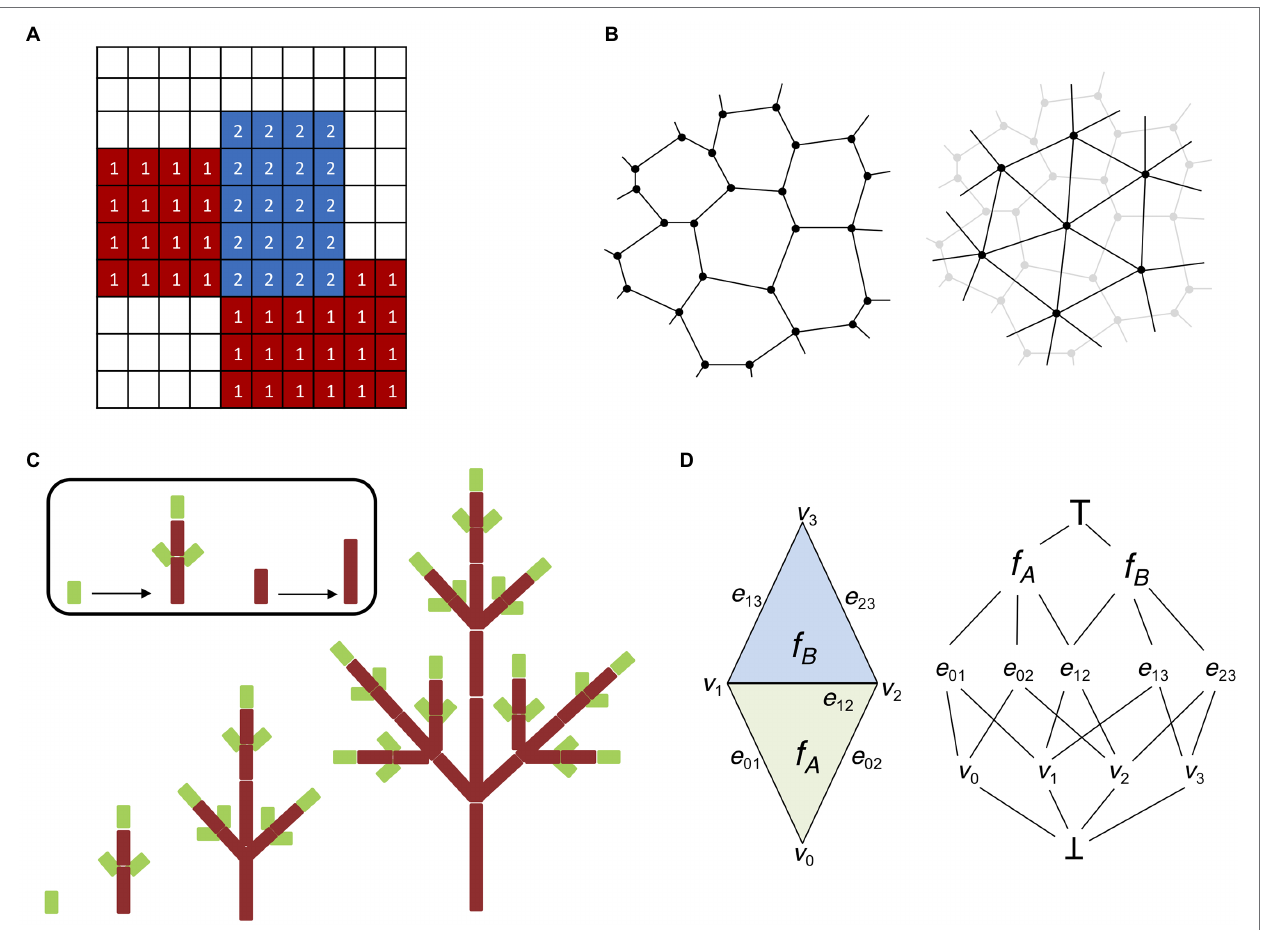
FIGURE 3 | Digital representations of plant tissues. (A) Lattice grid representing a basic cellular potts model (CPM). Each element (or pixel) of the grid possesses a specific identity; in this case, we have two cellular types (indicated by 1 and 2) and a medium (no labeling). CPMs are solved by minimizing the Hamiltonian energy of the system, which allows the elements of each cellular type to “group together” and isolate from the surrounding medium. (B) Two possible ways to represent multicellular tissues with vertex-based models. Cells can be identified by their cell walls (left). Cell walls are represented as polygons made of vertices connected by edges shared with adjacent cells (in accordance with the biological properties of plant cell walls). Cells can be identified by their centroid (right). Cells are represented by a network of vertices and edges connecting the centroids of adjacent cells. Cell walls and boundaries can be abstracted in several ways, i.e., using Voronoi partitioning (Mosca et al., 2018). (C) L-systems modeling (adapted from Prusinkiewicz et al., 2018). An idealized realization of an L-system simulation is shown. The different stages of development of a simple tree branching structure are obtained from simple axioms and recursively applying procedural rules to a small group of elements. (D) Schematic representation of the “cell complex.” A simple two-dimensional cell complex made of two connected triangles (left) can be represented as an incident graph (right). Notice how the three cell dimensions (vertices, edges, and faces) occupy three different levels and share boundaries with each other. There are also two pseudocells and ┬ as the infimum and supremum of the incidence graph (see Prusinkiewicz and Lane, 2013 for ┴